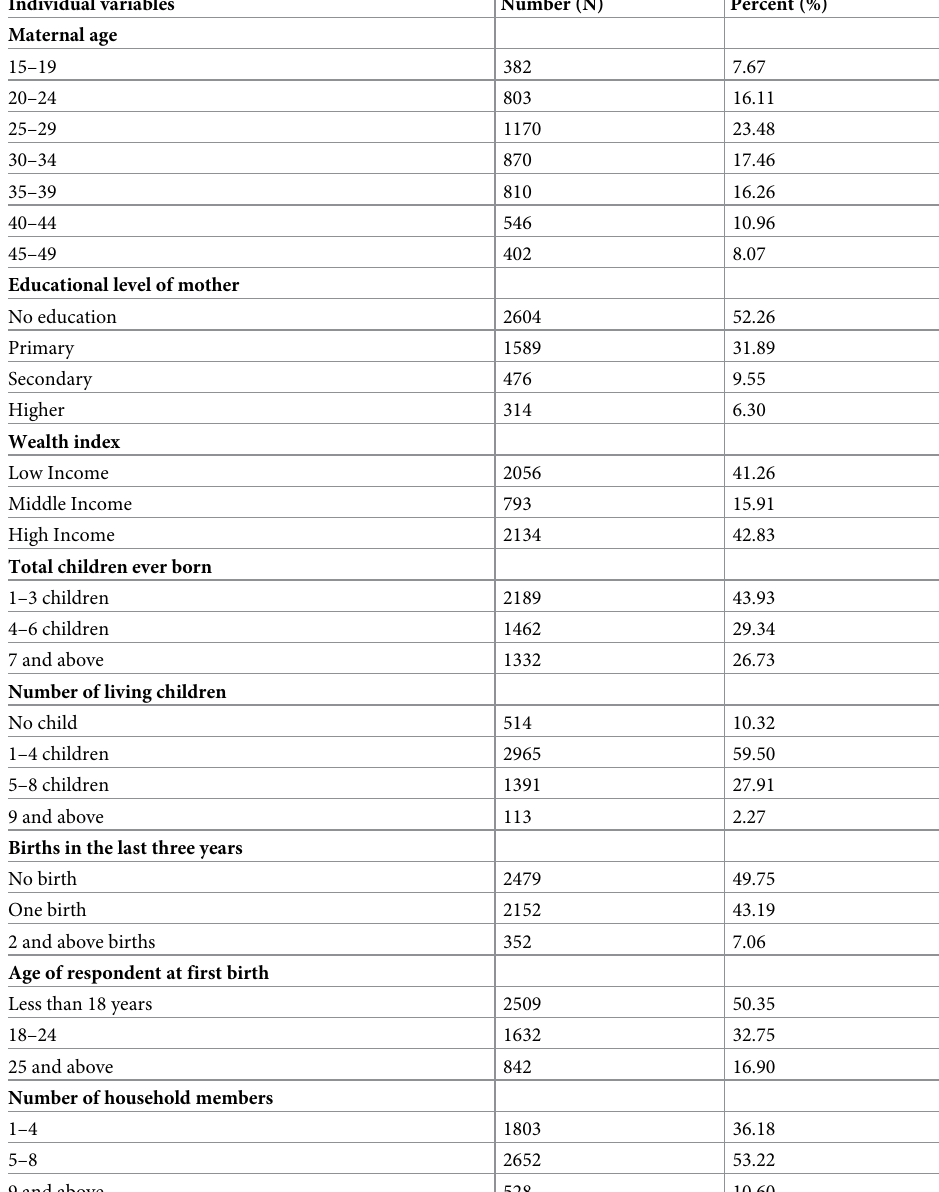
Table 2. Distribution of individual and community-level factors of the married women in Ethiopia, EMDHS 2019. Individual variables Number (N) Percent (%) Maternal